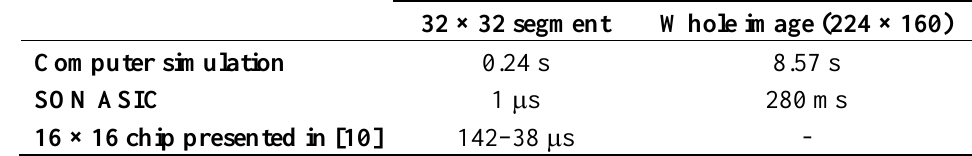
Table 1. Analysis times of image from Figure 12(a) using different